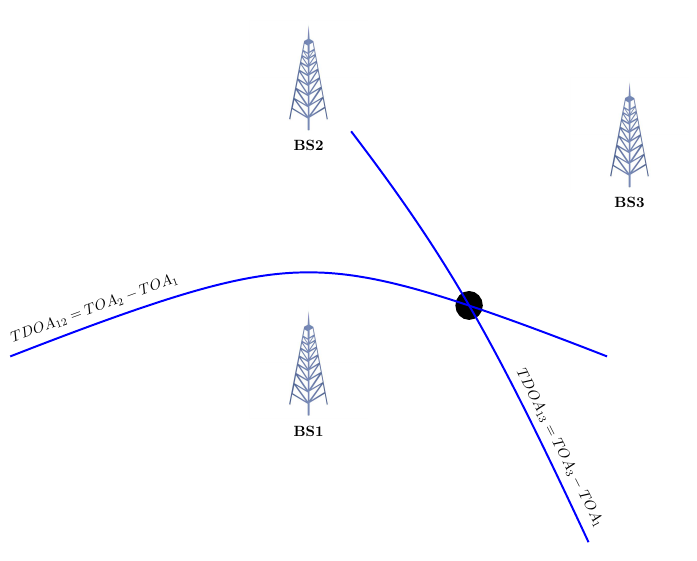
Figure 2. Localisation based on TDOA, the intersection of the hyperbolas.